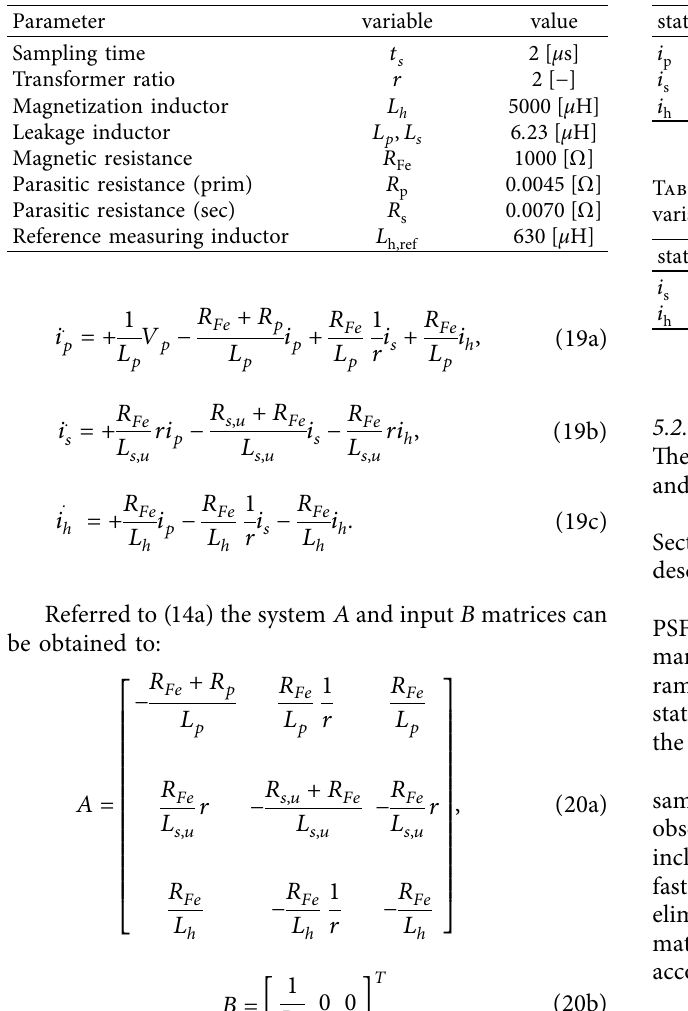
Table 2: Poles of system matrix A for the three state variables i and i of transformer model. h